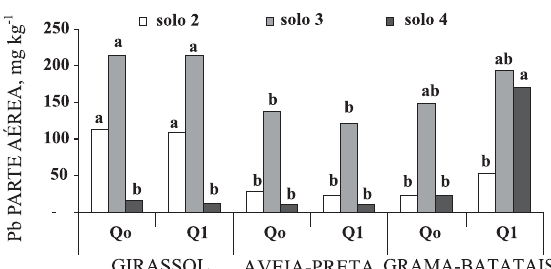
Figura 4. Concentrações de Pb nas partes aéreas das plantas nos solos sob influência direta das atividades de mineração. Qo: tratamento sem quelante; Q1: tratamento com quelante. Médias seguidas de mesma letra para o mesmo solo (barra de mesma tonalidade) e mesma cultura não diferem entre si pelo teste de Tukey a 5